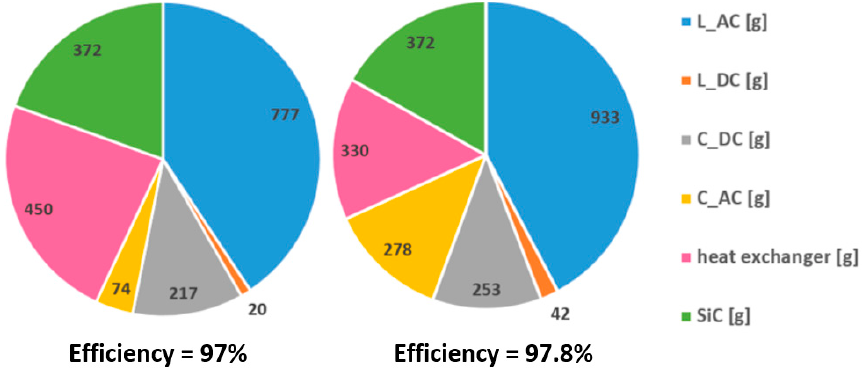
Figure 12. Optimal weight repartition considering the heat exchanger weight.